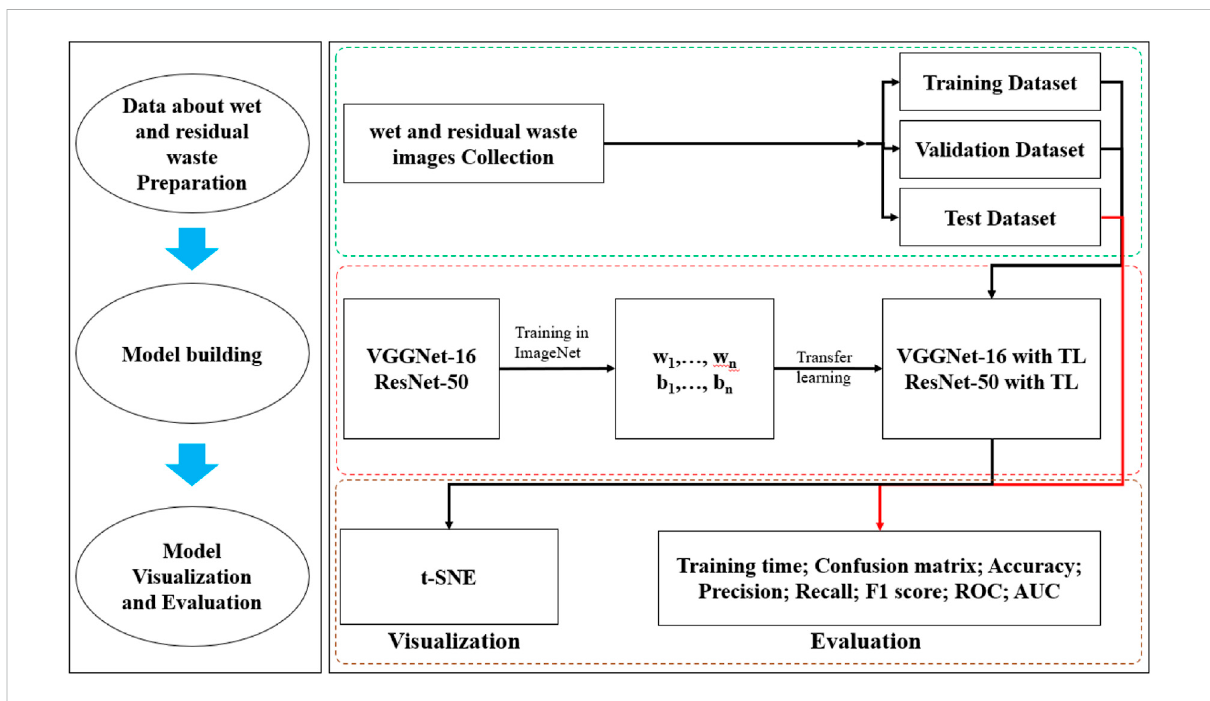
FIGURE 1 The fl owchart of this